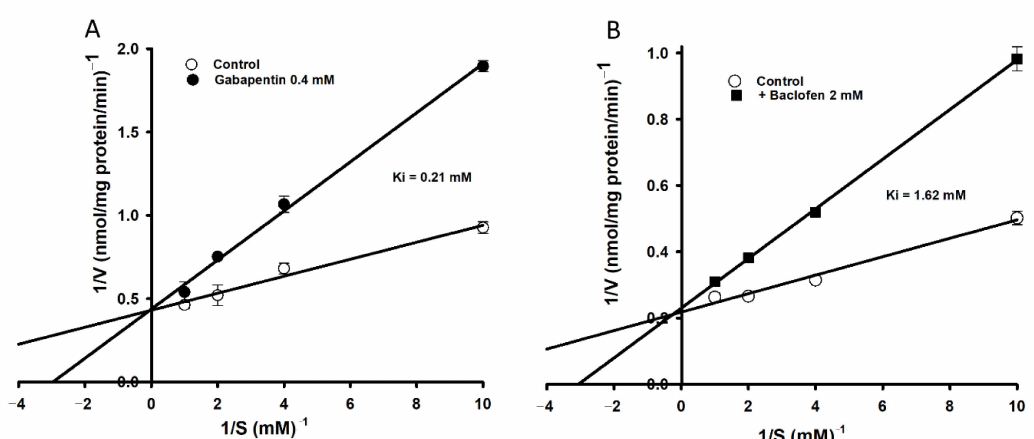
Figure 2. Lineweaver-Burk plots of [ 3 H] L -tryptophan uptake by TR-BBB cell lines showing competitive inhibition. The uptake was performed at 37 ◦ C for 5 min in the presence ( • / (cid:4) ) or absence ( baclofen (2 mM, (cid:4) ). Each point represents the mean ± SEM ( n =